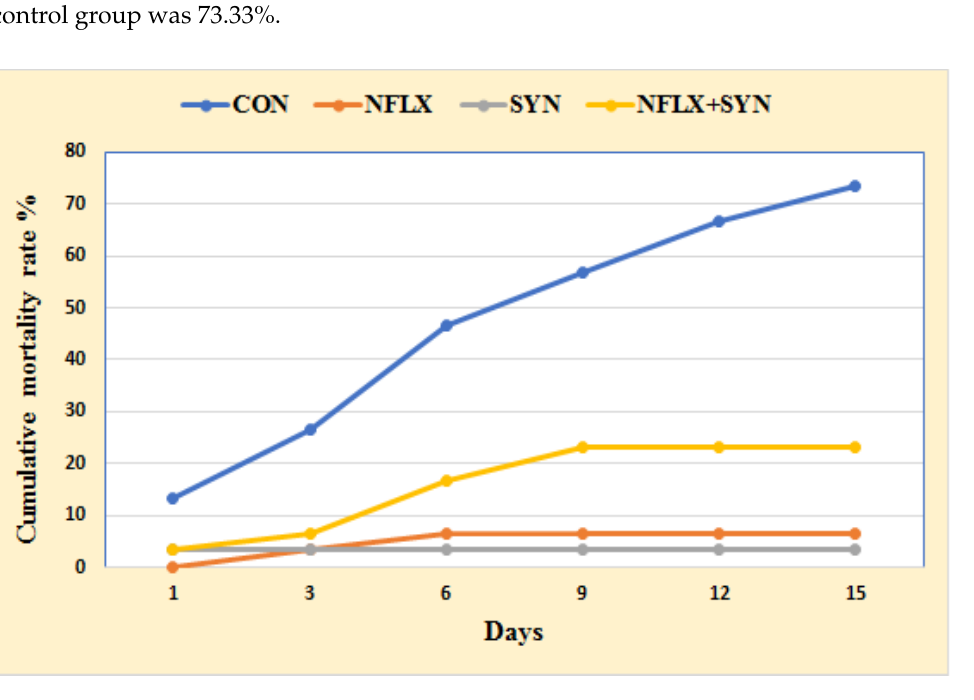
Figure 1. The cumulative mortality rate (%) of Nile tilapia fed with an antibiotic (norfloxacin NFLX) and synbiotic (SYN) after eight weeks and experimentally challenged with P. aeruginosa .